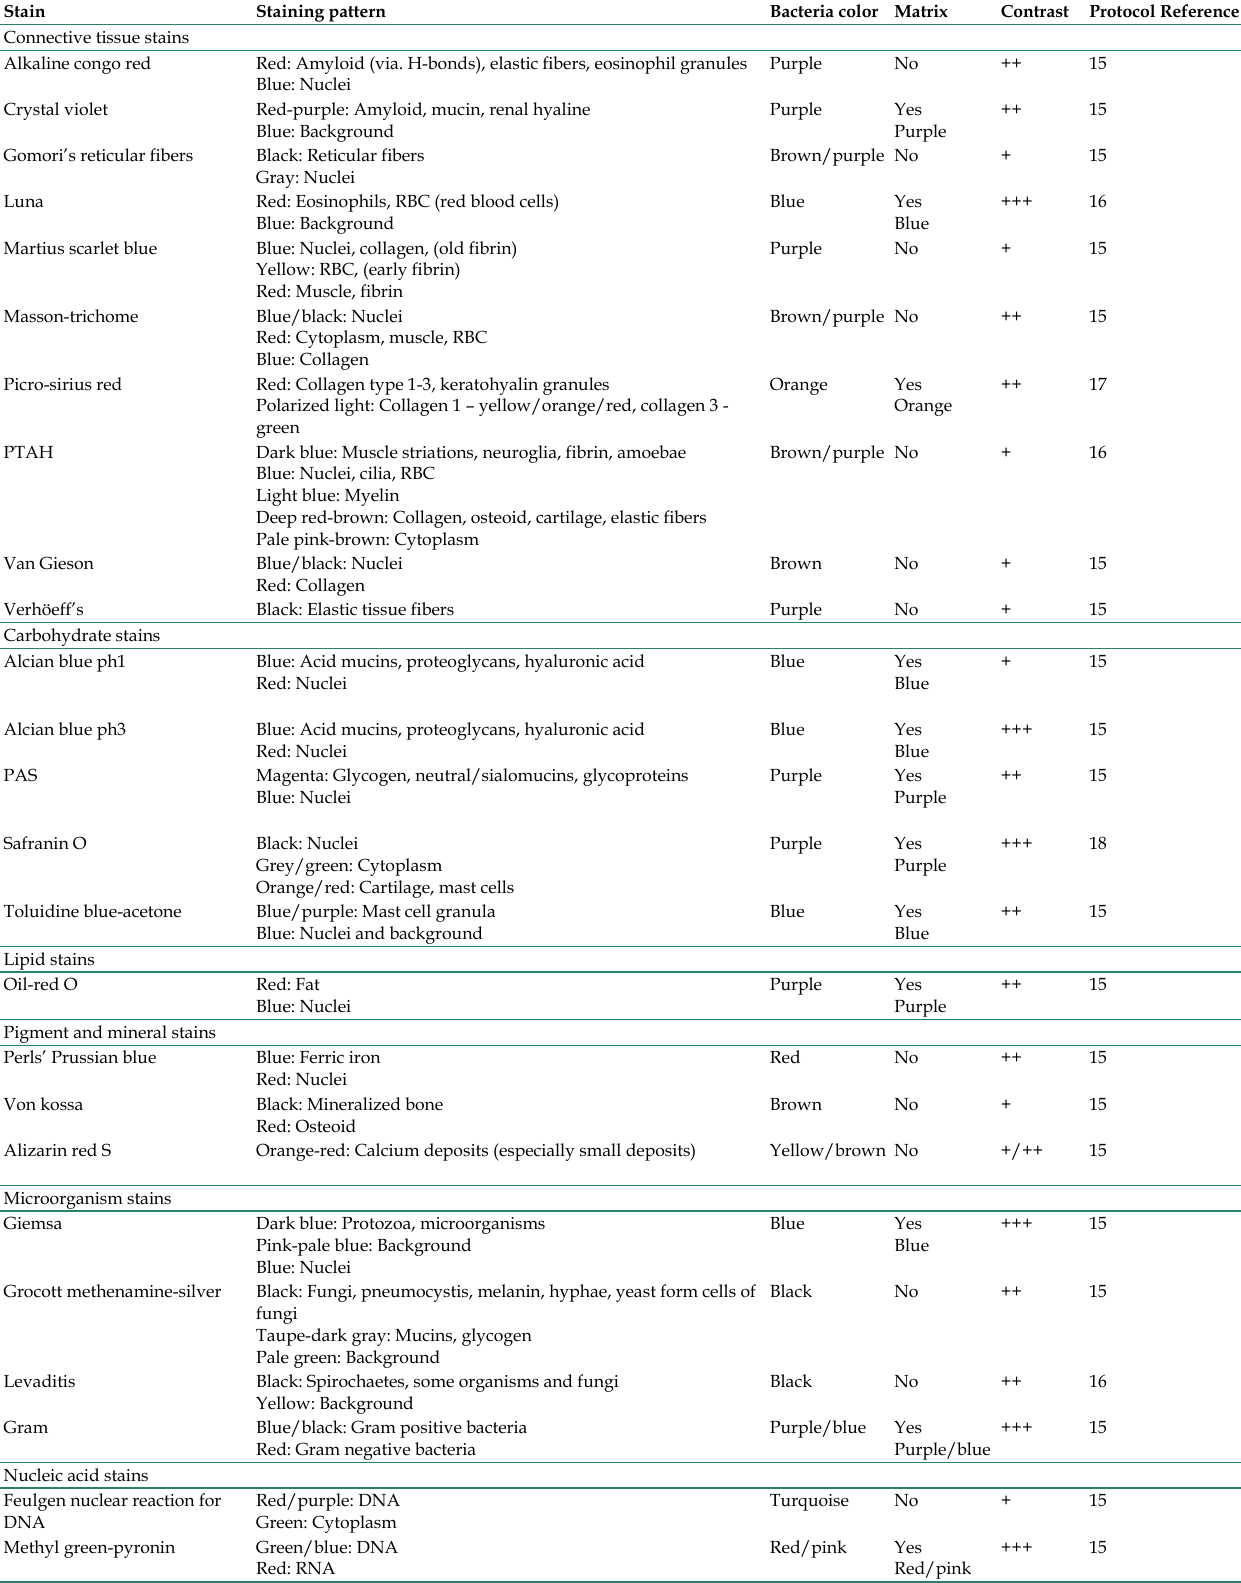
Purple No ++ 15 Purple Yes ++ 15 Purple Brown/purple No + 15 Blue Yes +++ 16 Blue Purple No + 15 Brown/purple No ++ 15 Orange Yes ++ 17 Orange Brown/purple No + 16 Brown No + 15 Blue Yes + 15 Blue Blue Yes +++ 15 Blue Purple Yes ++ 15 Purple Purple Yes +++ 18 Purple Blue Yes ++ 15 Blue Purple Yes ++ 15 Purple Red No ++ 15 Brown No + 15 Blue Yes +++ 15 Blue Black No ++ 15 Black No ++ 16 Purple/blue Yes +++ 15 Purple/blue Turquoise No + 15 Red/pink Yes +++ 15 Red/pink